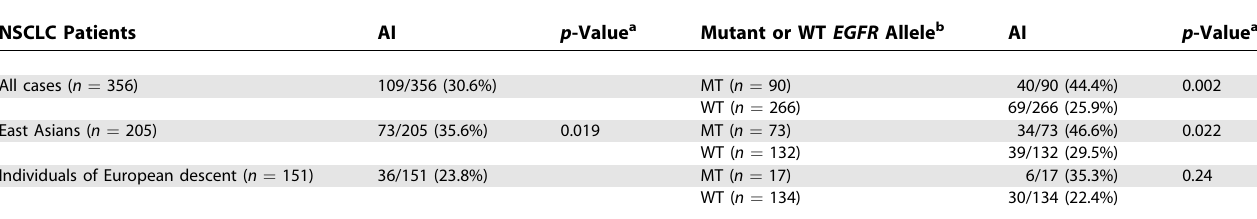
Table 7. Frequencies of AI of Either Allele of CA-SSR1 by Ethnicity NSCLC Patients